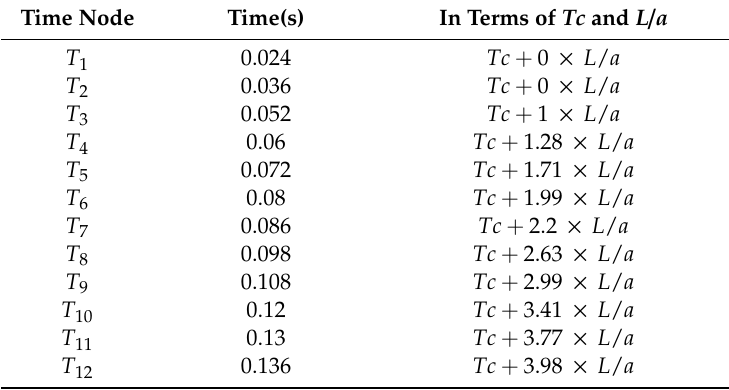
Table 3. Time nodes of T 1 ∼ T 12 in terms of Tc and L / a